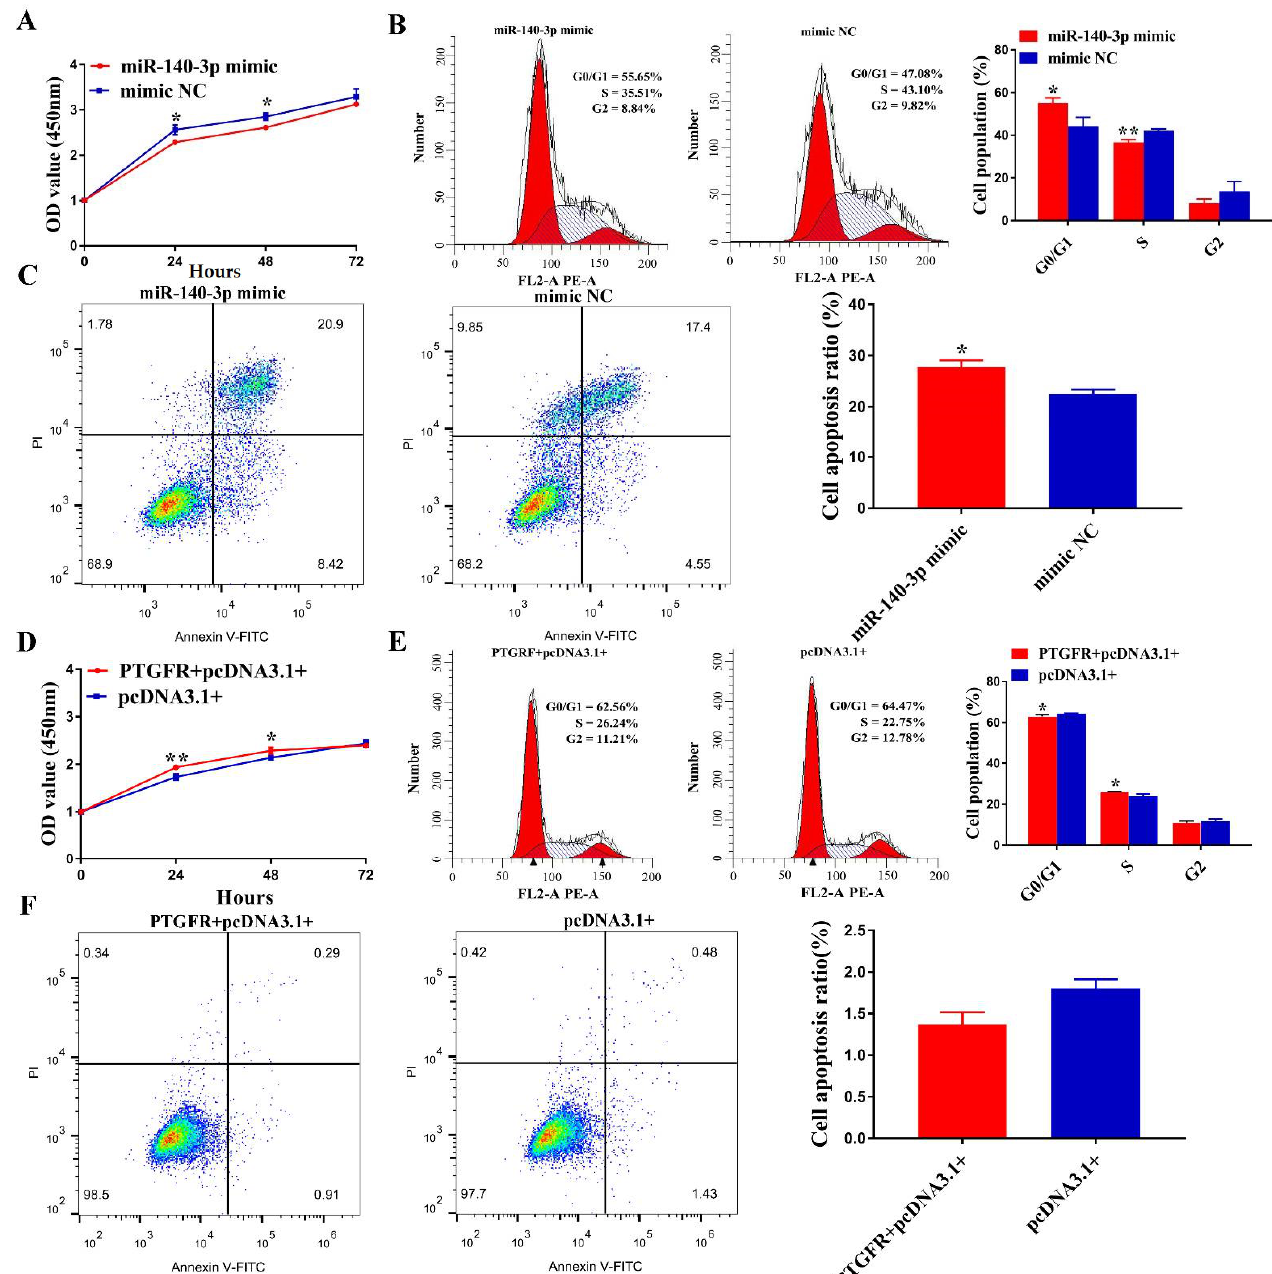
Figure 6. MiR-140-3p suppresses EECs proliferation, and cell cycle and induces apoptosis targeting PTGFR. ( A ) The proliferative ability of EECs transfected with miR-140-3p-mimic or mimic-NC was demonstrated by CCK-8. ( B ) Cell cycle progression was assessed by FACS assays in EECs transfected with miR-140-3p mimic or mimic NC. ( C ) The apoptosis rate of EECs after miR-140-3p mimic transfection was measured by FACS. ( D ) CCK-8 demonstrated the ability of EECs to proliferate with PTGFR or pcDNA3.1+ overexpression vectors. ( E ) The cell cycle PTGFR + pcDNA3.1 + transfected EECs was estimated by flow cytometry. ( F ) The apoptosis rate of EECs transfected with PTGFR and FACS determined pcDNA3.1 + overexpression vectors. Data are presented as mean ± SD of 3 subjects. * p < 0.05, ** p < 0.01.